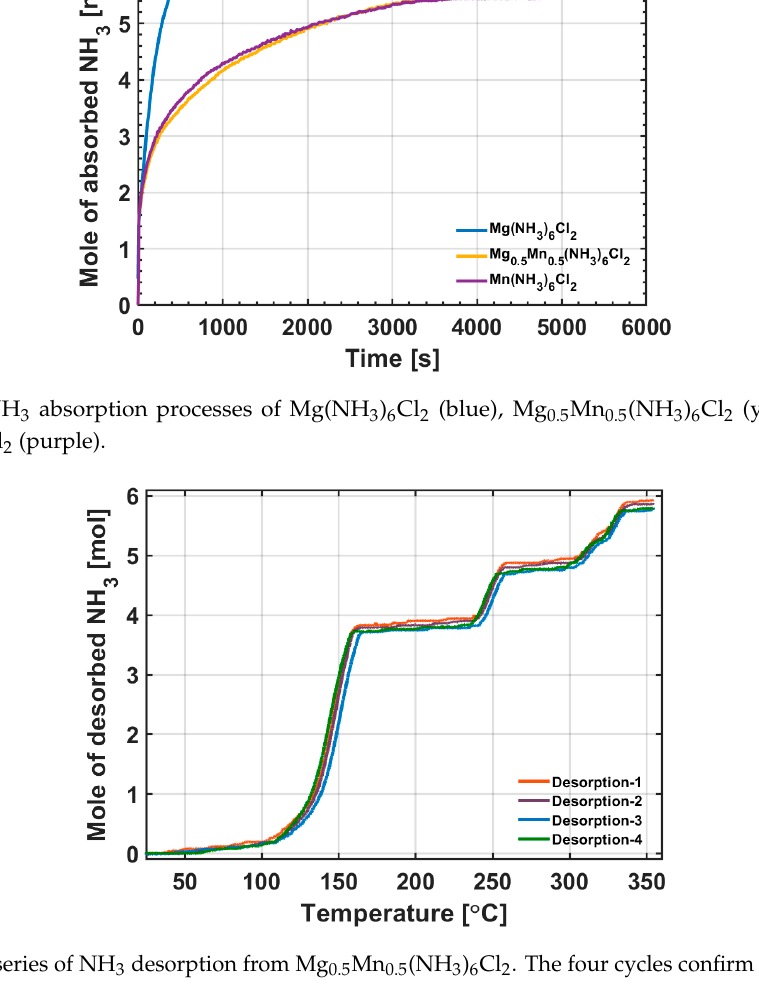
Figure 7. NH 3 absorption processes of Mg(NH 3 ) 6 Cl 2 (blue), Mg 0.5 Mn 0.5 (NH 3 ) 6 Cl 2 (yellow) and Mn(NH 3 ) 6 Cl 2 (purple).